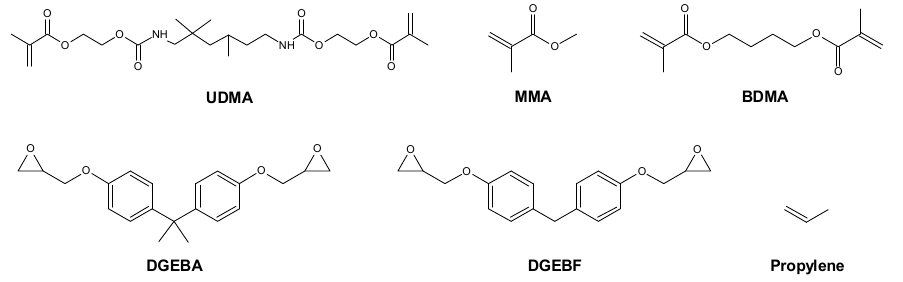
Figure 1. Structural formulas of monomers, which are the basis for the resins in the present study: urethane dimethacrylate (UDMA), methyl methacrylate (MMA), 1,4-butanediol dimethacrylate (BDMA), bisphenol A diglycidyl ether (DGEBA), bisphenol F diglycidyl ether (DGEBF) and propylene